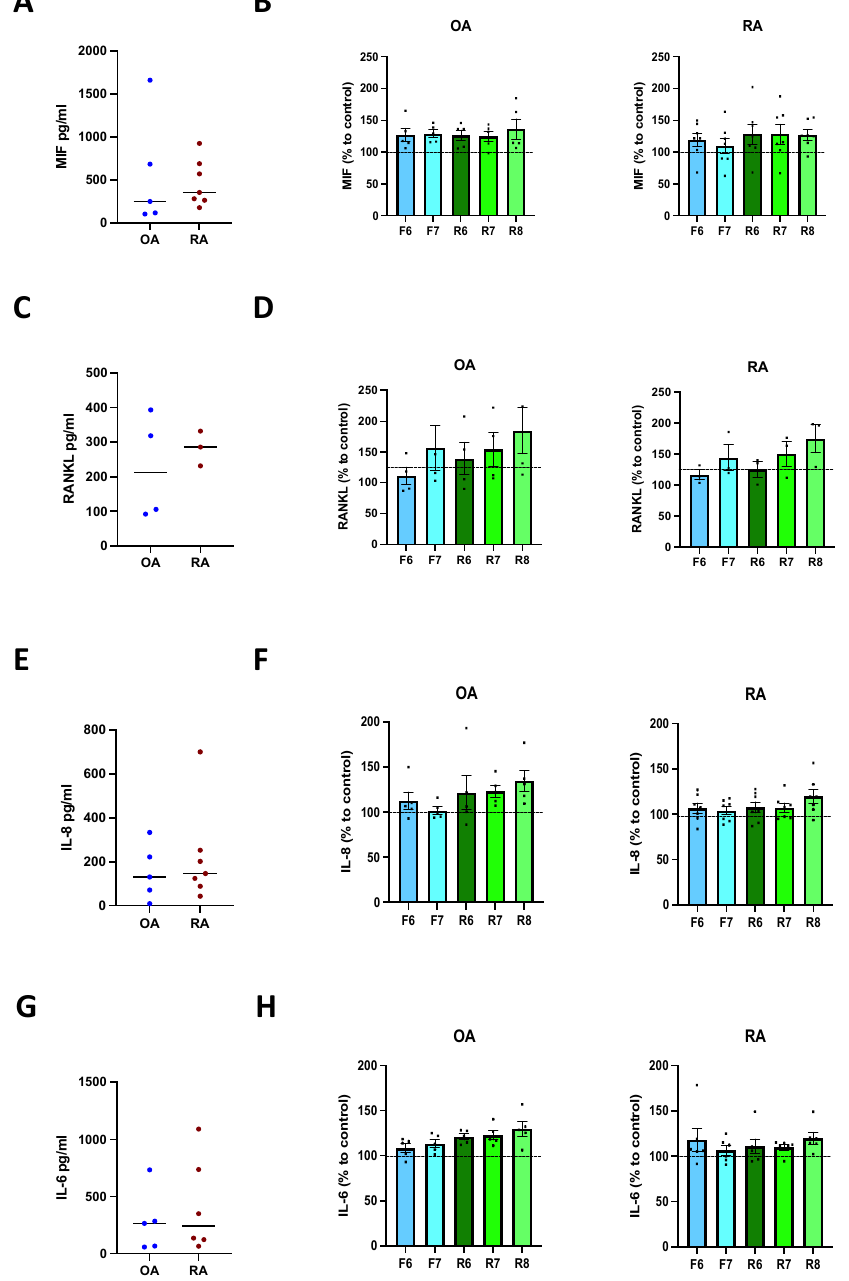
Figure 6. Cytokine release after DR stimulation of activated osteoblasts. Isolated osteoblasts were cultured for 3 weeks with mineralization medium, and afterwards for further 24 h in presence of specific DR agonists. Afterwards, cytokines were measured in culture supernatants. ( A ): basal amount of macrophage migration inhibitory factor (MIF) in OA and RA patients. ( B ): quantification of MIF in OA ( left ) and RA ( right ) patients expressed as percentage to control without DR agonist. ( C ): basal amount of receptor activator of nuclear factor- κ B ligand (RANKL) in OA and RA